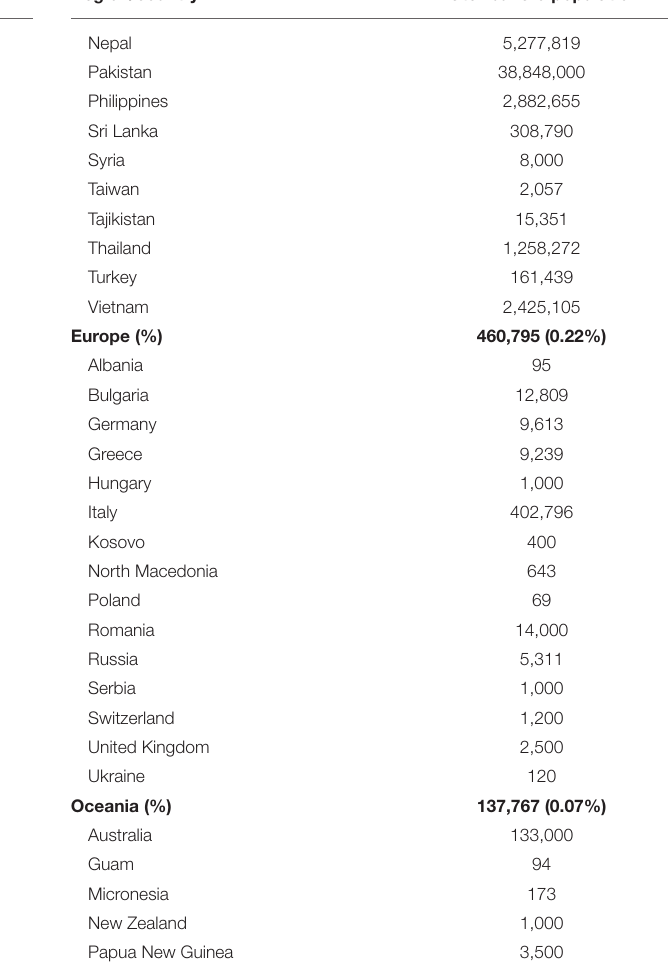
data from buffalo herds worldwide. Supplementary Table